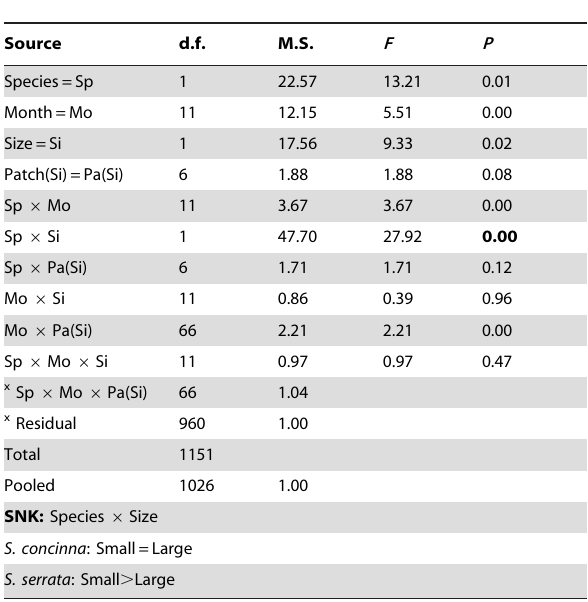
Table 4. Analysis of variance comparing densities of adult Siphonaria concinna and S. serrata over 12 months in the Eastern Cape region.